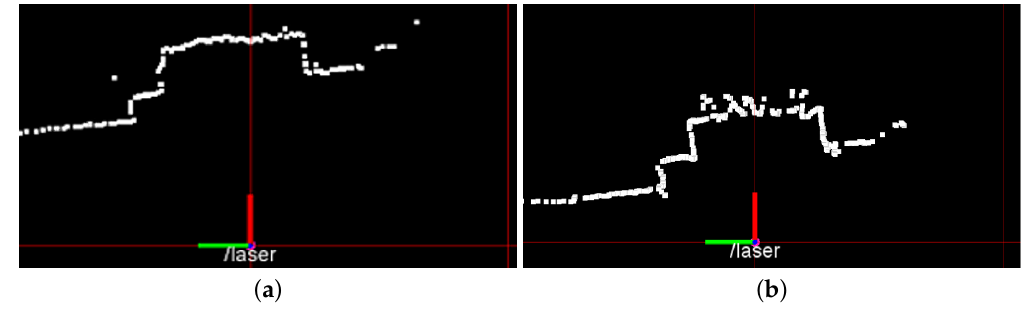
Figure 7. Noise caused by the grids on the laser range readings. Due to better angular resolution, the Hokuyo is affected by measurement noise due to metal grids covering the racks. ( a ) SICK LMS-200 laser scan; ( b ) Hokuyo 04LX laser scan.